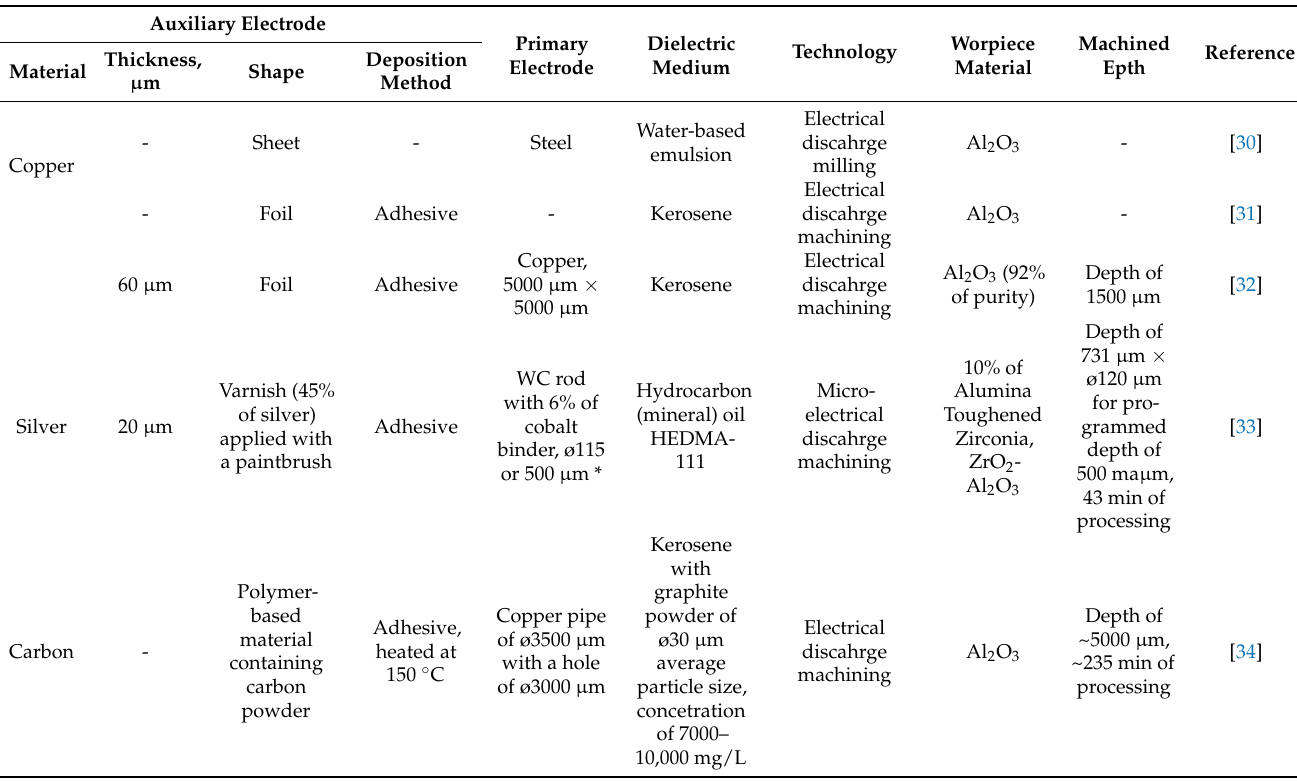
Table 2. Reported types of auxiliary